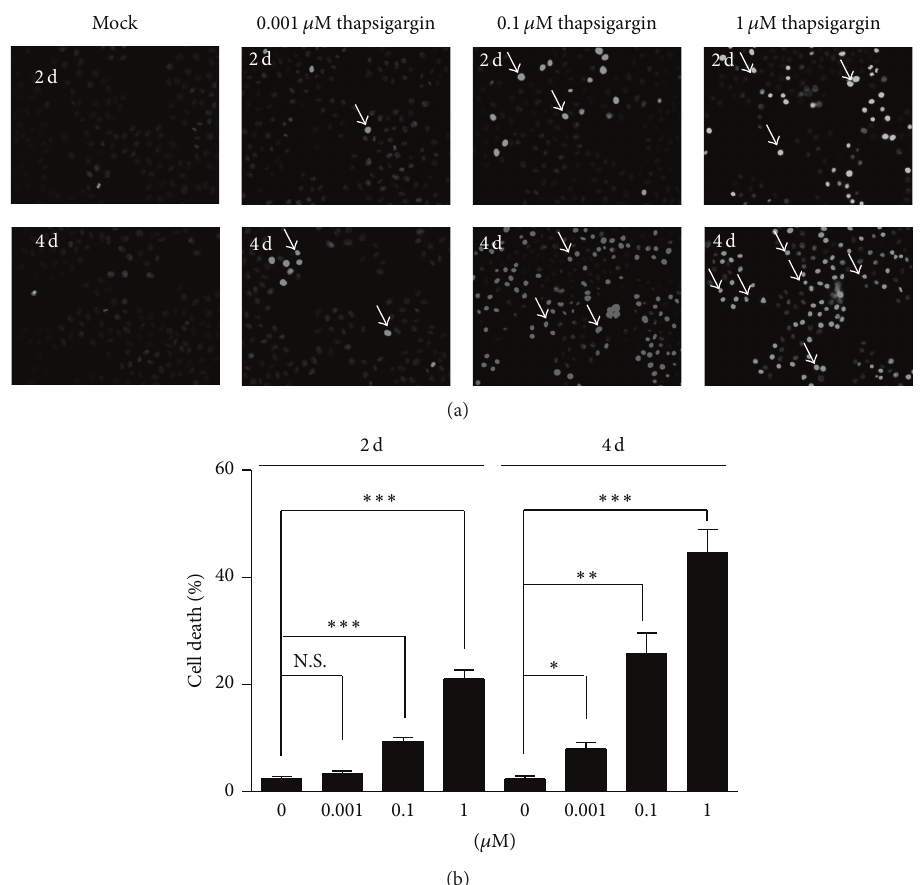
Figure 2: Thapsigargin induces cell apoptosis in MH7A cells. Hoechst stainings (a) and histograms (b) showing the increased cell death (%) after thapsigargin treatment in MH7A cells. Results are averages of three independent experiments. Data represent mean ± SEM. ∗ 𝑃 < 0.05 , ∗∗ 𝑃 < 0.01 , ∗∗∗ 𝑃 < 0.001 , and N.S.: not statistically